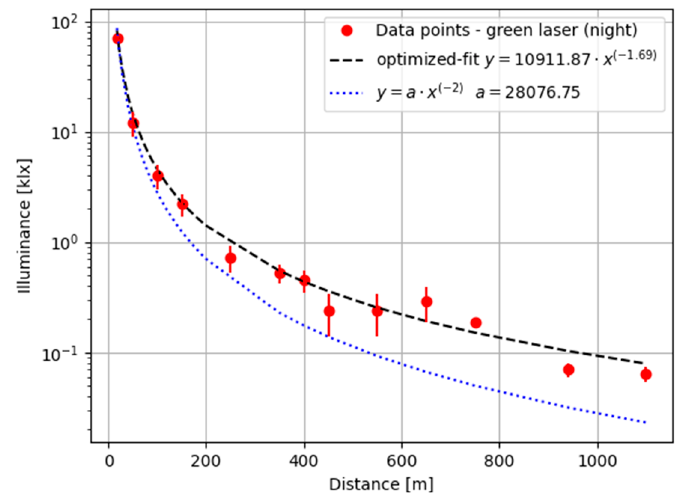
Figure 7. The dependence of the illuminance on the distance of the green laser at night. Table 3. Summary of the experimental results.